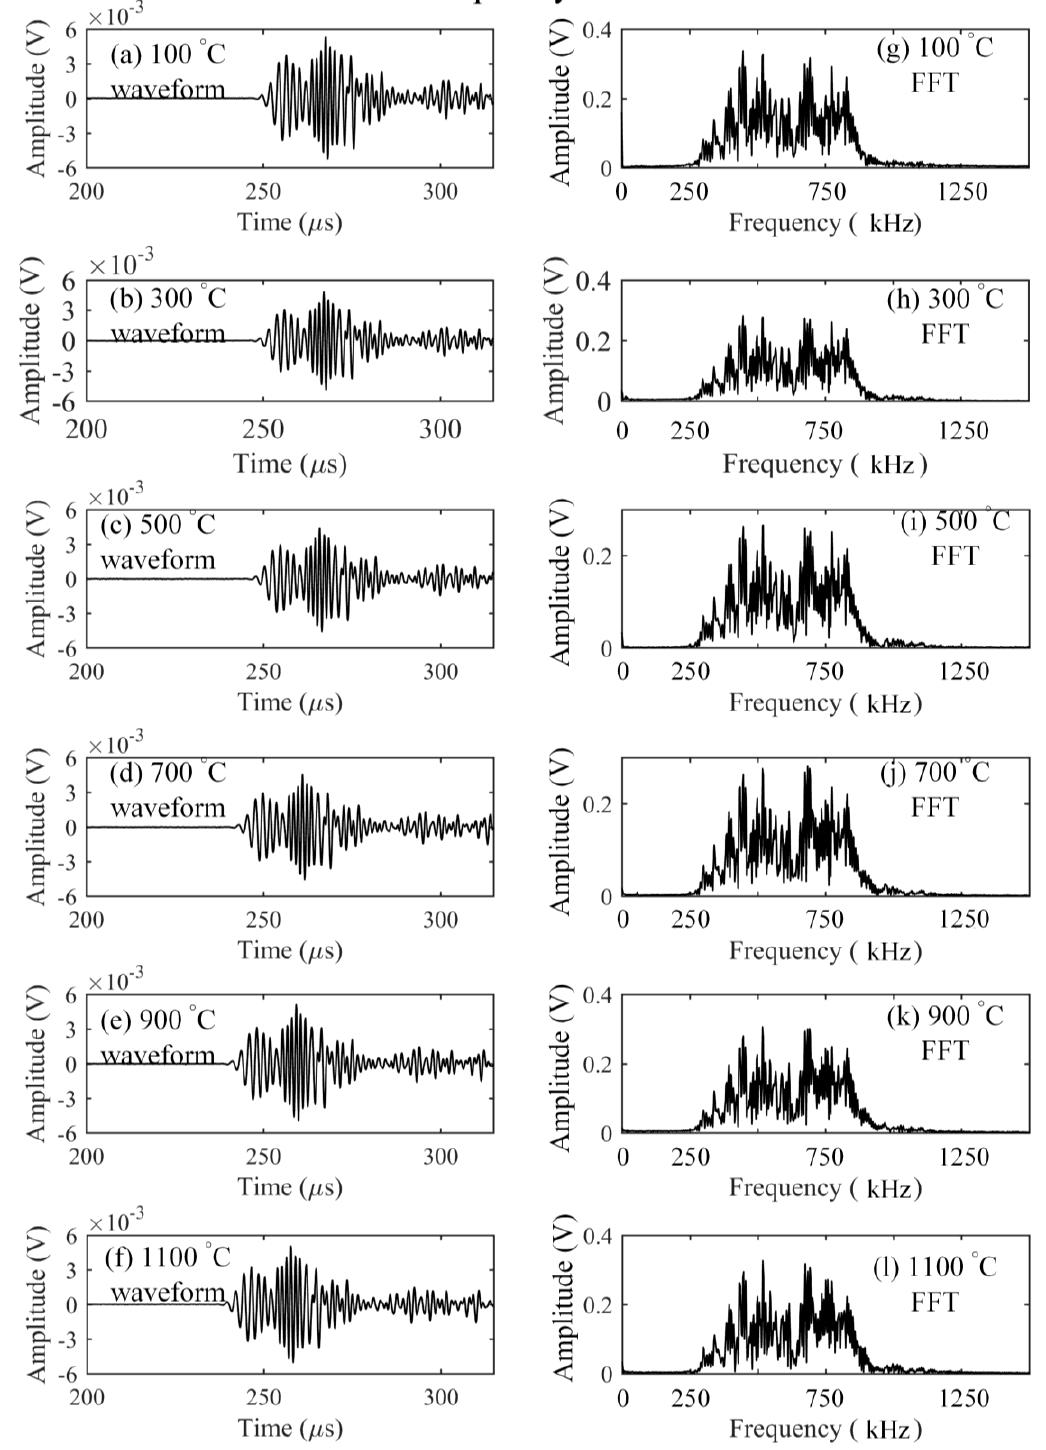
Figure 5. Responses to an ultrasonic wave with a center frequency of 600 kHz.